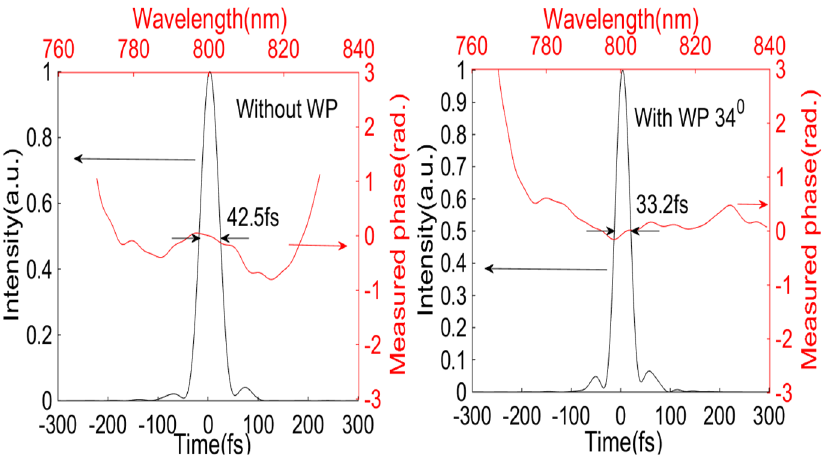
Figure 7. The measured pulse duration and spectral phase after optimizing the compressor, without WP and with WP at an angle of 34°.